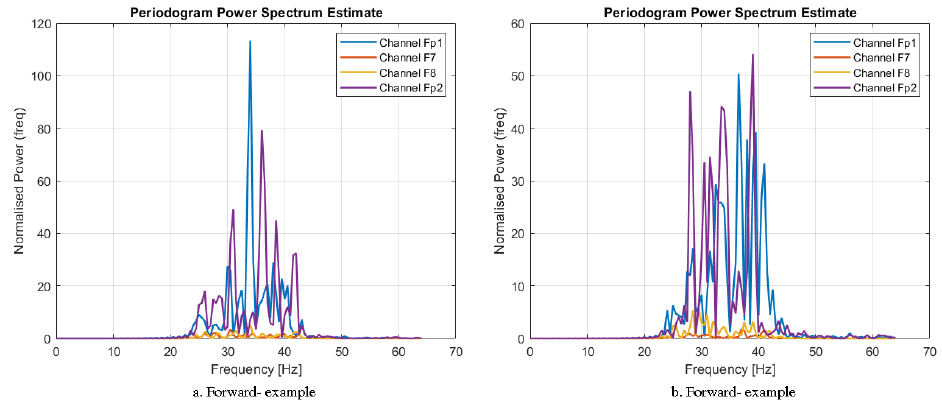
Figure 6. An example of the power spectrum estimation result for participants 1 and 2—calm.